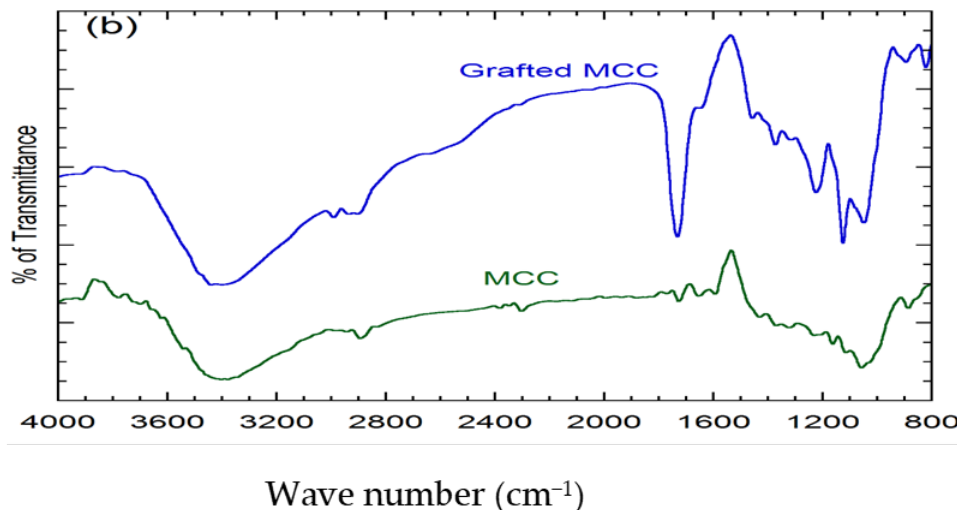
Figure 4. FTIR Spectra of α -cellulose and grafted α -cellulose ( a ), and MCC and grafted MCC ( b ).